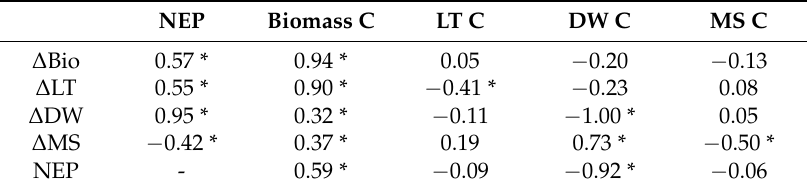
Table 4. Correlation coefficients between forest carbon (C) stocks and their changes ( Δ ).